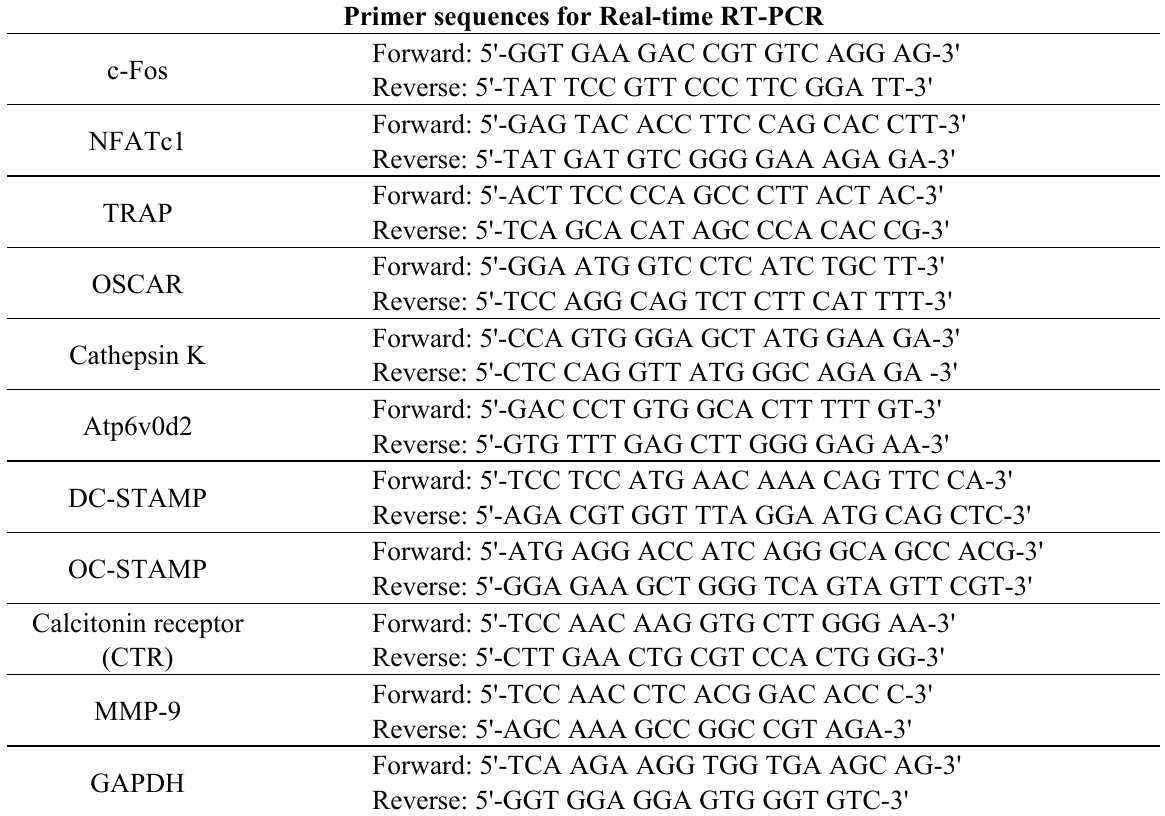
Table 1. Primer sequences used for real-time PCR